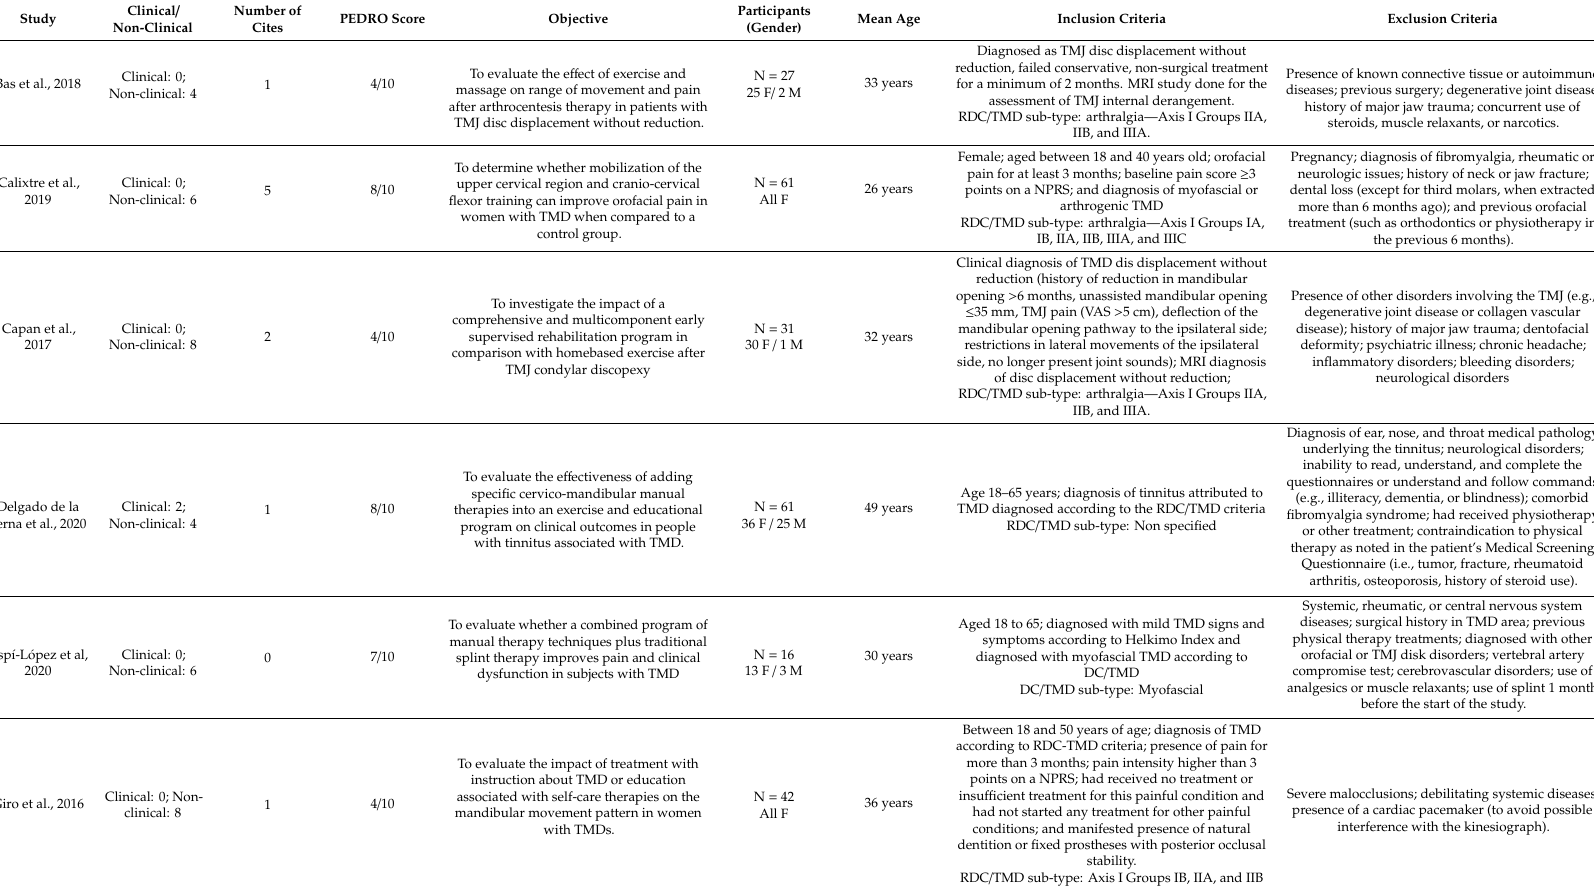
Table 2. Characteristics of clinical trials including patients with temporomandibular disorders according to the JCR criteria. F—Female; M—Male; MRI—Magnetic Resonance Imaging; TMD—Temporomandibular disorders; TMJ—Temporomandibular joint; RDC / TMD—Research Diagnostic Criteria for Temporomandibular disordes; DC / TMD—Diagnostic Criteria for Temporomandibular